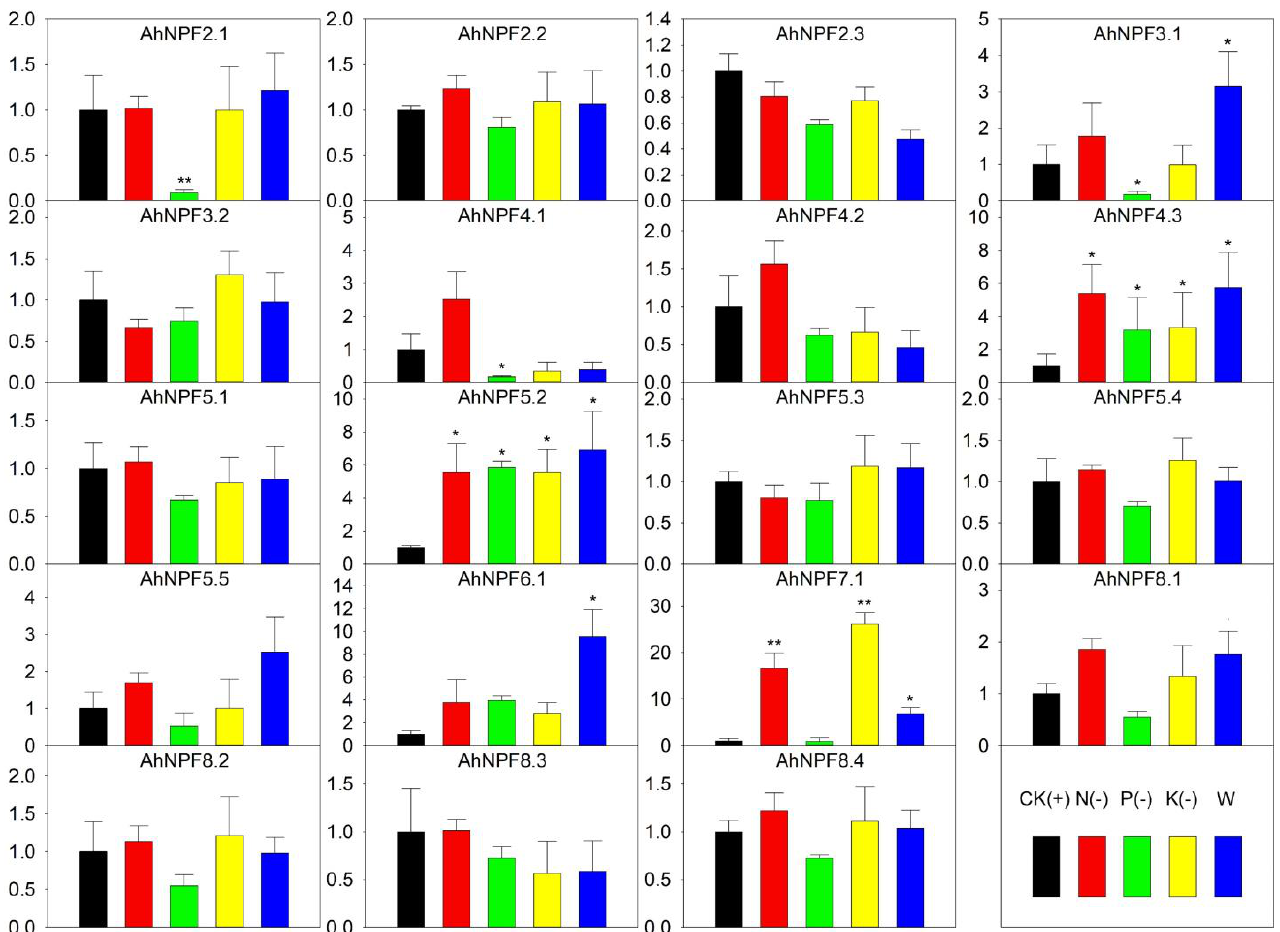
Figure 6. Expression pattern of agave NPF genes under nutrient deficiency by qRT-PCR. Y-axis represents relative expression level. CK, N(-), P(-), K(-) and W of x-axis represent that the agave seedlings were cultured with full-, nitrogen free-, phosphorus free-, potassium free-Hoagland nutrient solutions and water, respectively. The error bar represents the standard error. * and ** represent that expression level was increased or decreased by more than 3-fold and 10-fold compared with CK, respectively. The expression values of control were normalized as 1.